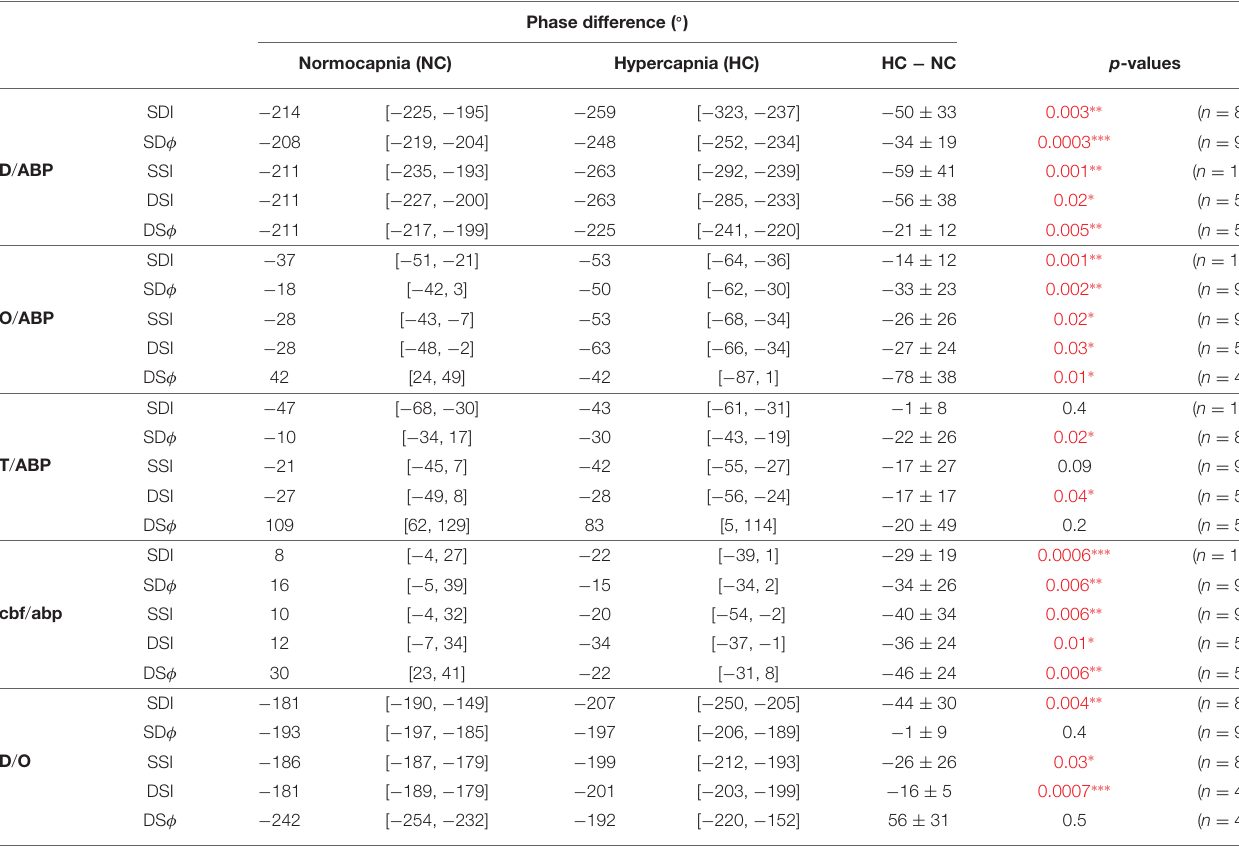
TABLE 2 | Values of the phase differences of phasors of deoxyhemoglobin ( D ) vs. arterial blood pressure ( ABP ), oxyhemoglobin ( O ) vs. ABP , total hemoglobin ( T ) vs. ABP , normalized cerebral blood flow ( cbf ) vs. normalized arterial blood pressure ( abp ), and D vs. O during normocapnia and